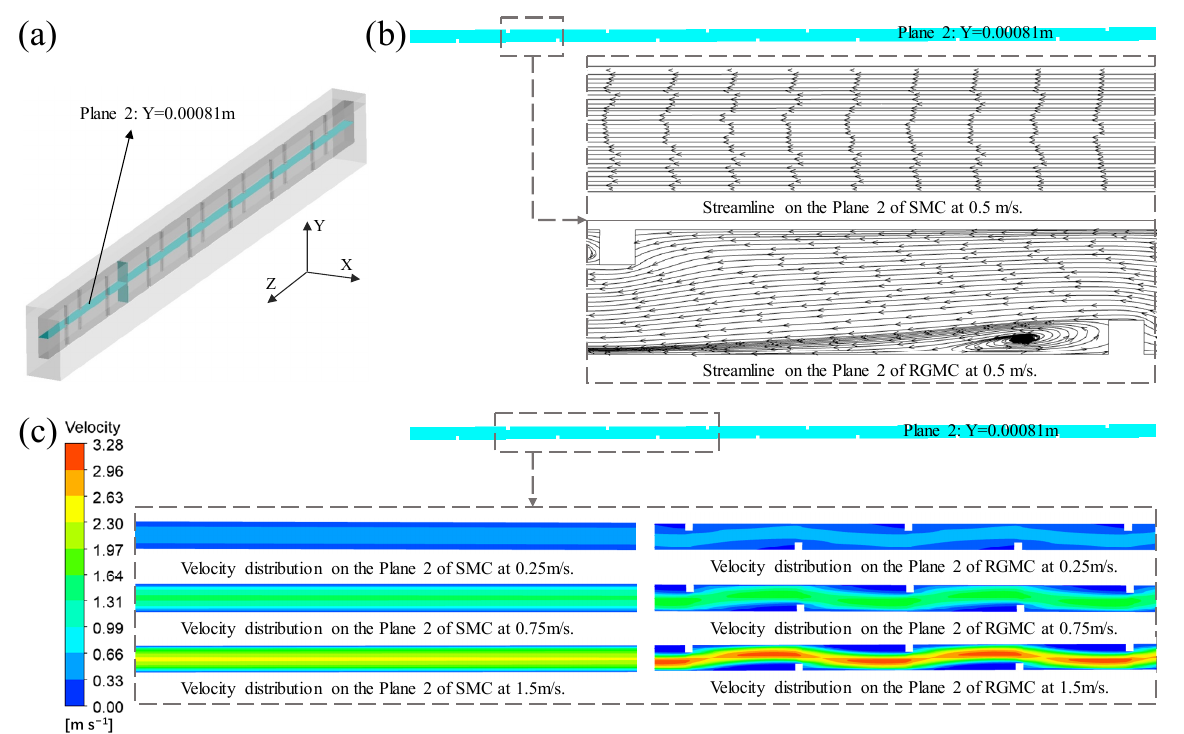
distribution on the Plane 2 of SMC at 0.25m/s. Velocity distribution on the Plane 2 of SMC at 0.75m/s. Velocity distribution on the Plane 2 of SMC at 1.5m/s.